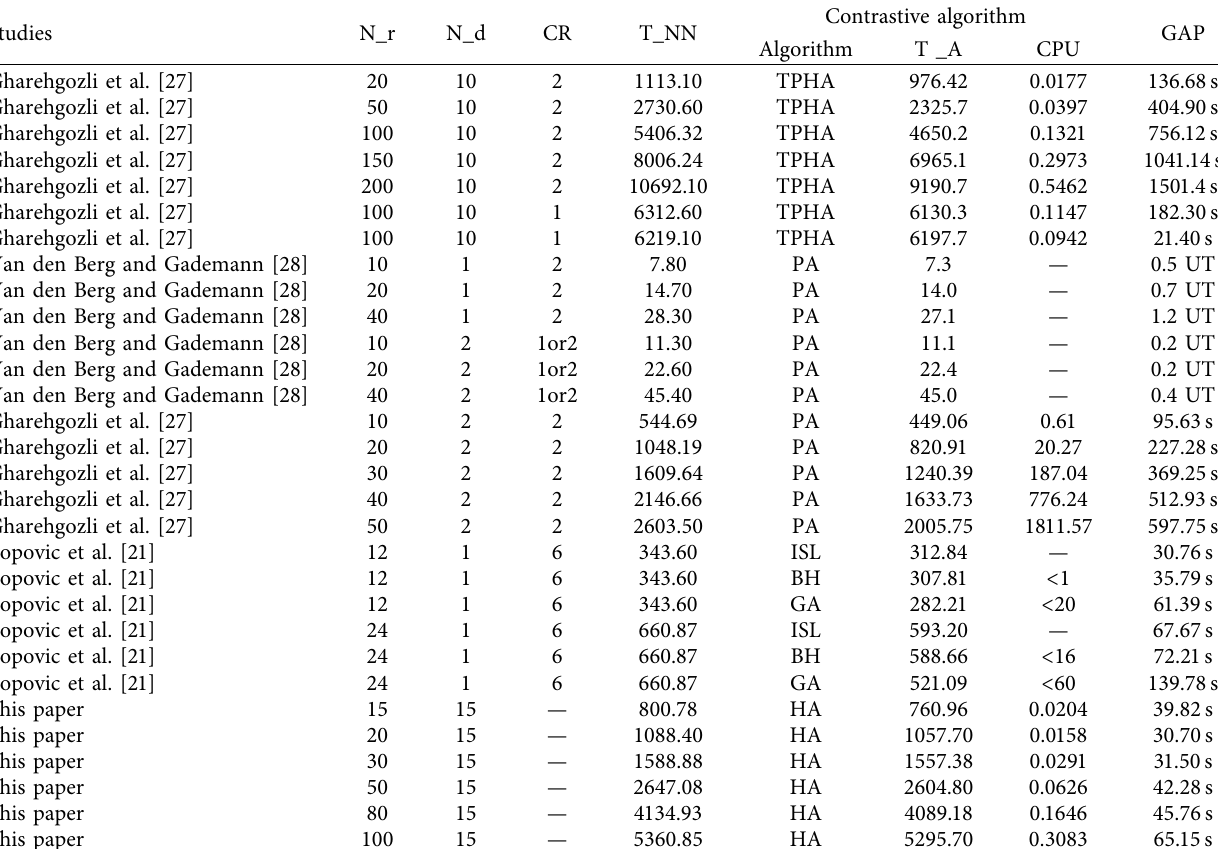
Table 6: Comparisons of existing methods with the proposed